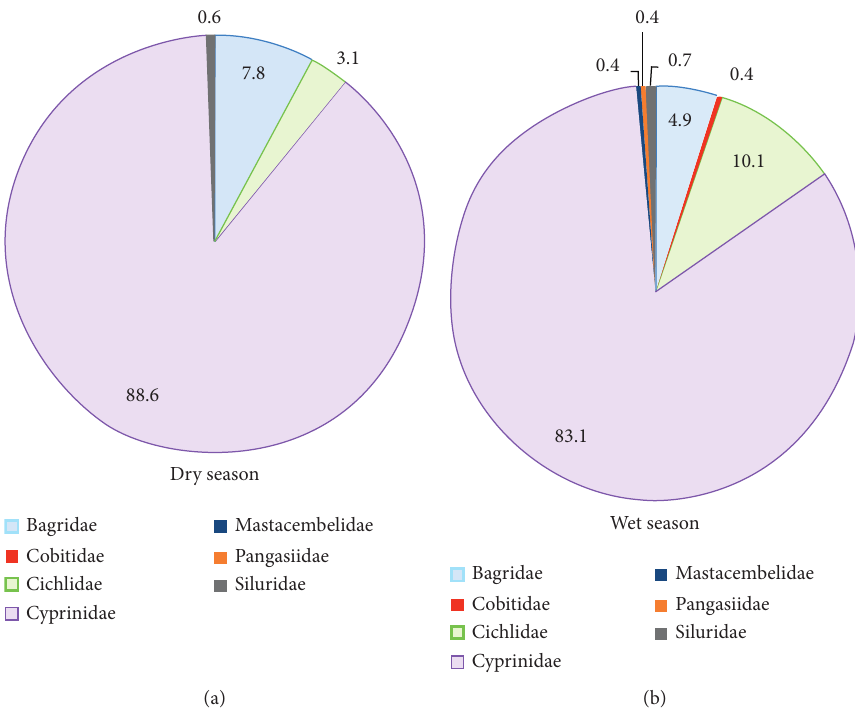
Figure 2: The overall percentage of the fish family recorded in the study